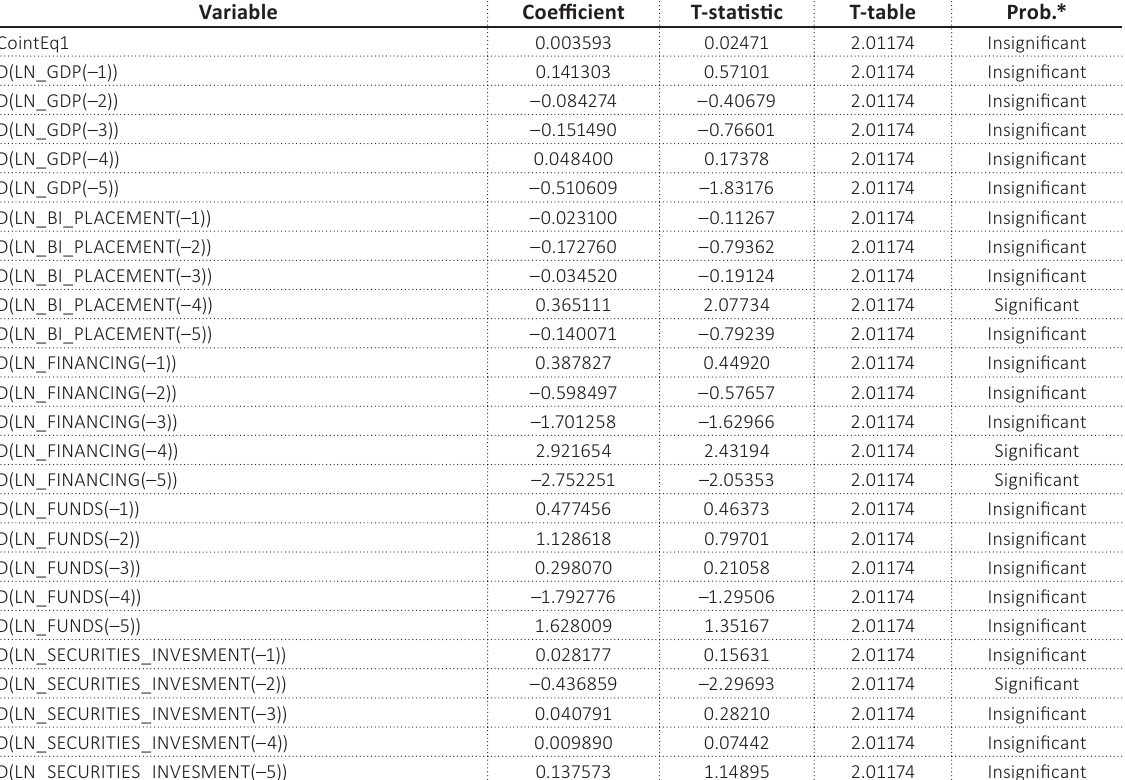
Table 5. VECM short-run